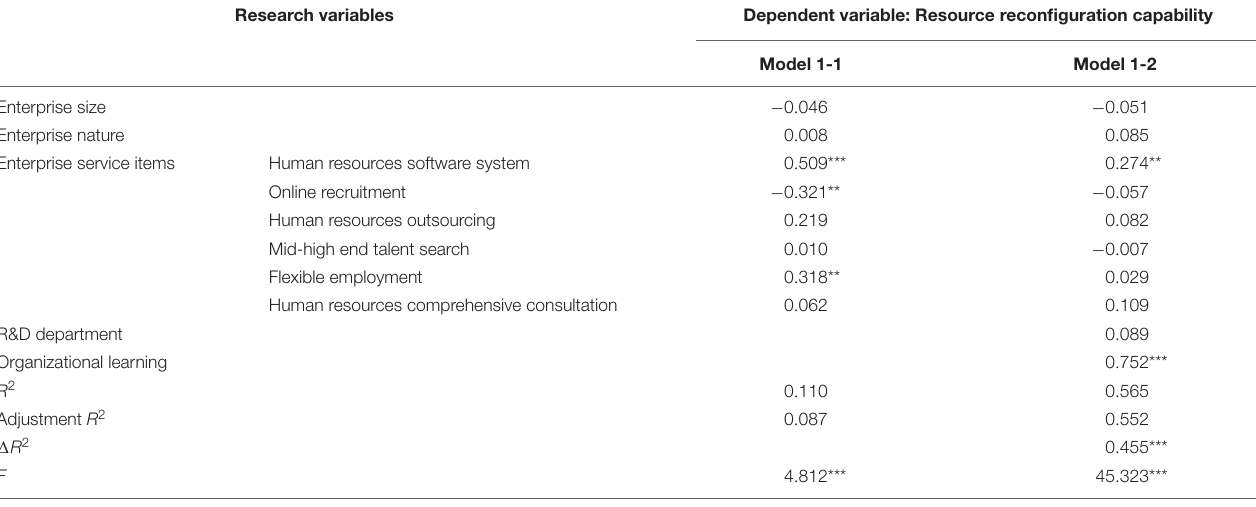
TABLE 6 | Regression analysis results of organizational learning on resource reconfiguration capability.